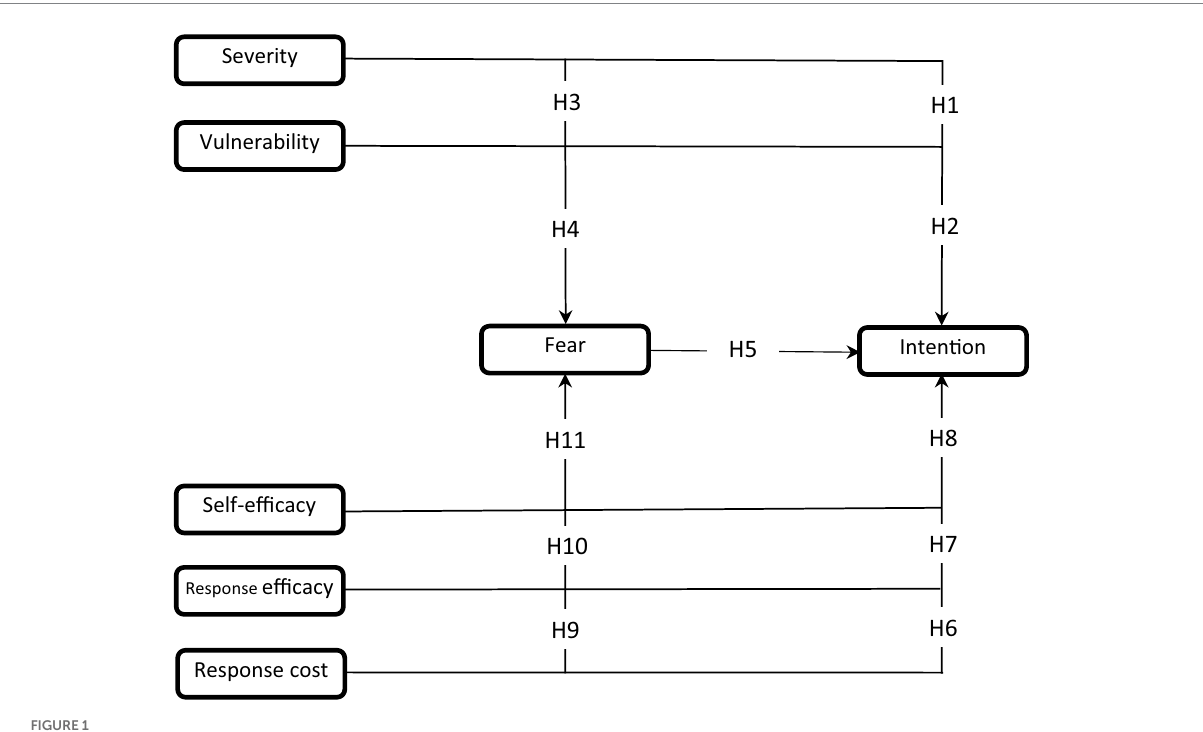
FIGURE 1 Theoretical model of the